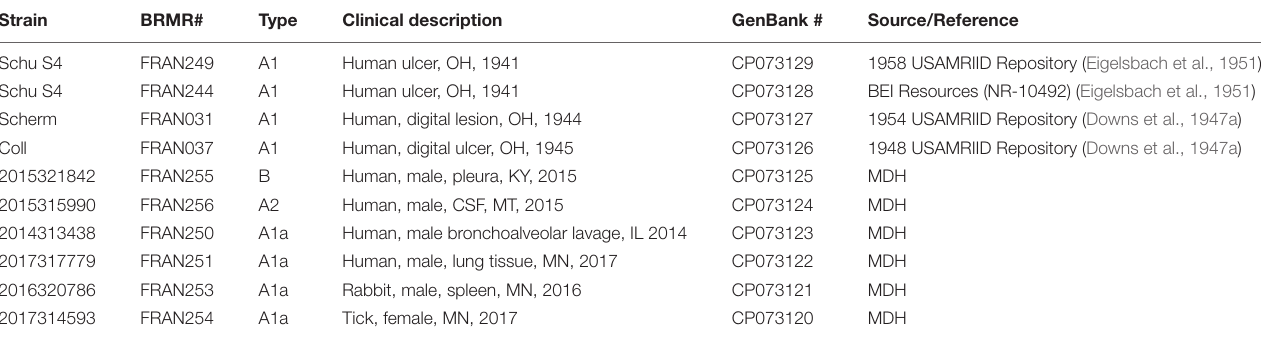
TABLE 1 | Francisella tularensis strains used in this